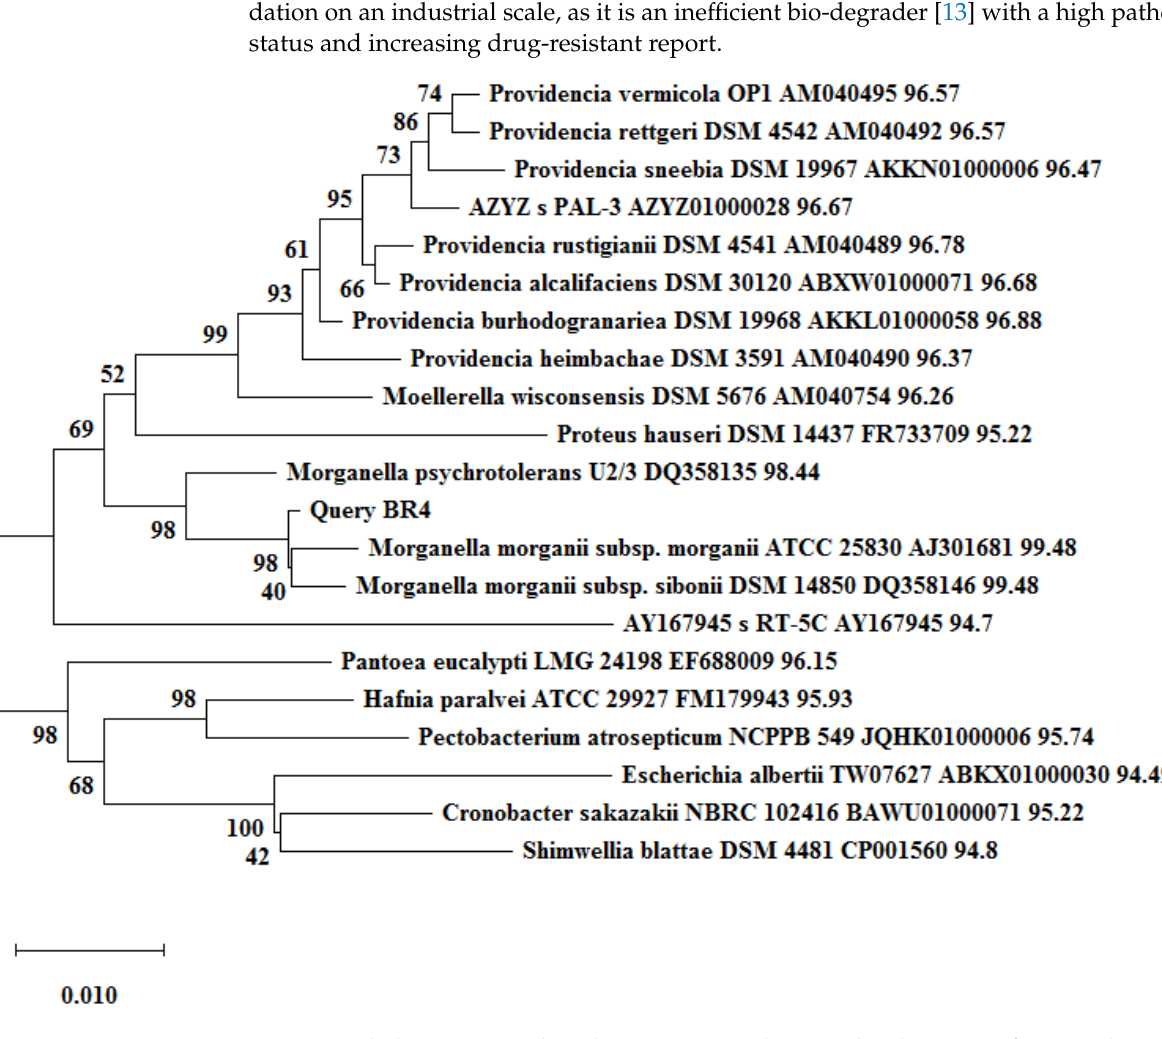
Figure 6. Phylogenetic tree based on 16S-rRNA showing the clustering of BR4 with sequences retrieved form the EzBioCloud database. The tree was constructed in MEGAX by the neighbor-joining method with a 500 bootstrap value.